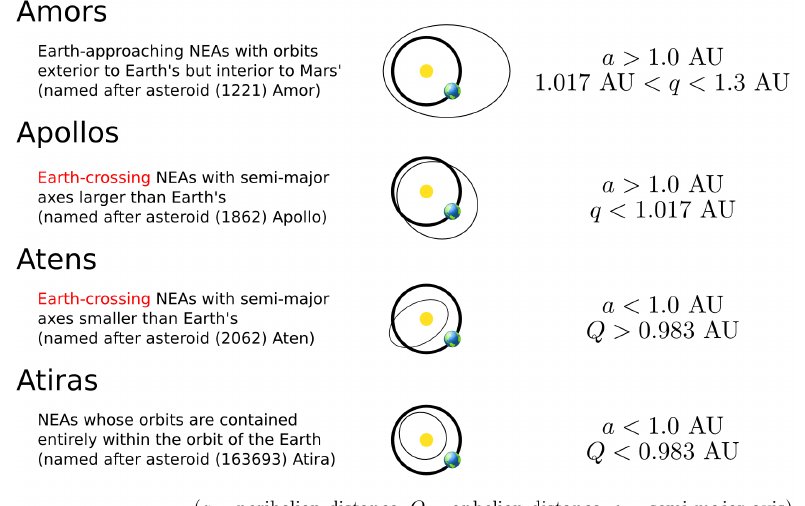
Figure 13. Four types of near-Earth asteroids known as Atira, Aten, Apollo, and Amor [137]. As of 1 May 2022, there are a total of 28,874 NEOs discovered and surveyed [138]. Only 117 (0.4%) of them are NECs, and the remaining are all NEAs. Furthermore, as illustrated in Figure 14, 10,070 of all NEAs are NEA-140 m (with diameters 140 m and larger), while 877 are NEA-km (with diameters 1 km and larger). Moreover, 2262 and 156 of all NEOs are categorized into PHA and PHA-km, respectively [138]. Eventually, the orbits of all known PHOs can be plotted for real-time tracking, such as in Figure 15.